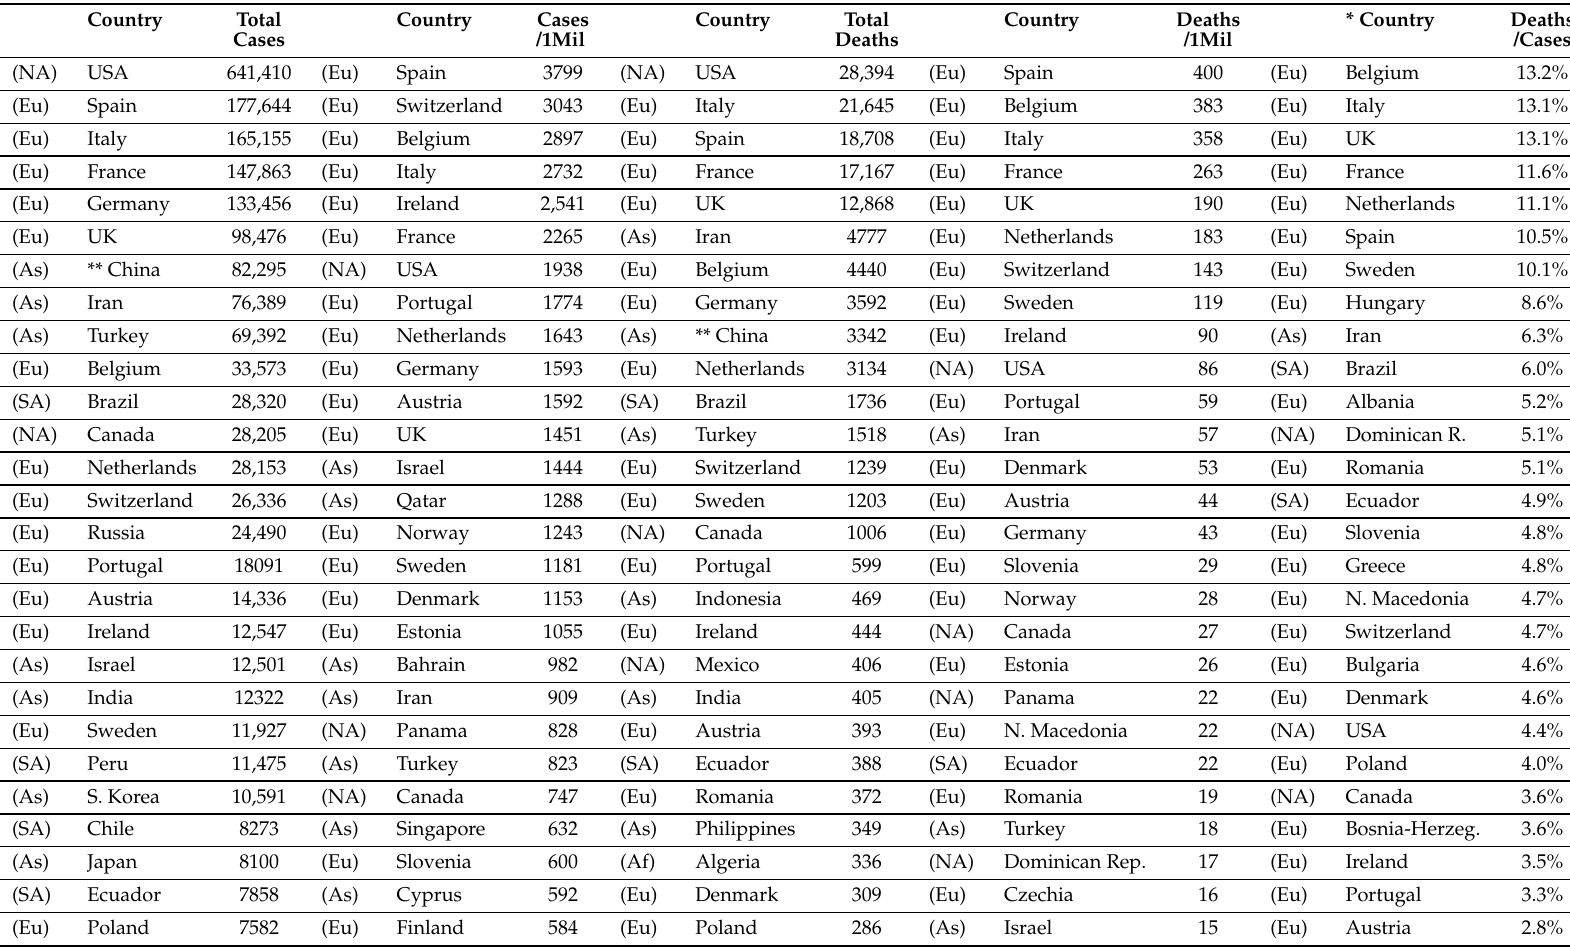
Table 1. Statistics of the first fifty-six countries (with more than one million people) most affected by the COVID-19 pandemic according to four metrics as of 15 April 2020. (Eu) Europe; (NA) North America; (SA) South America; (As) Asia; (Af) Africa; (AO) Australia-Oceania. * For countries with Cases/1Mil > 100. ** On 17 April 2020, China corrected the record and reported 82,692 cases and 4632 total deaths. The complete table is found in the Supplementary Materials.